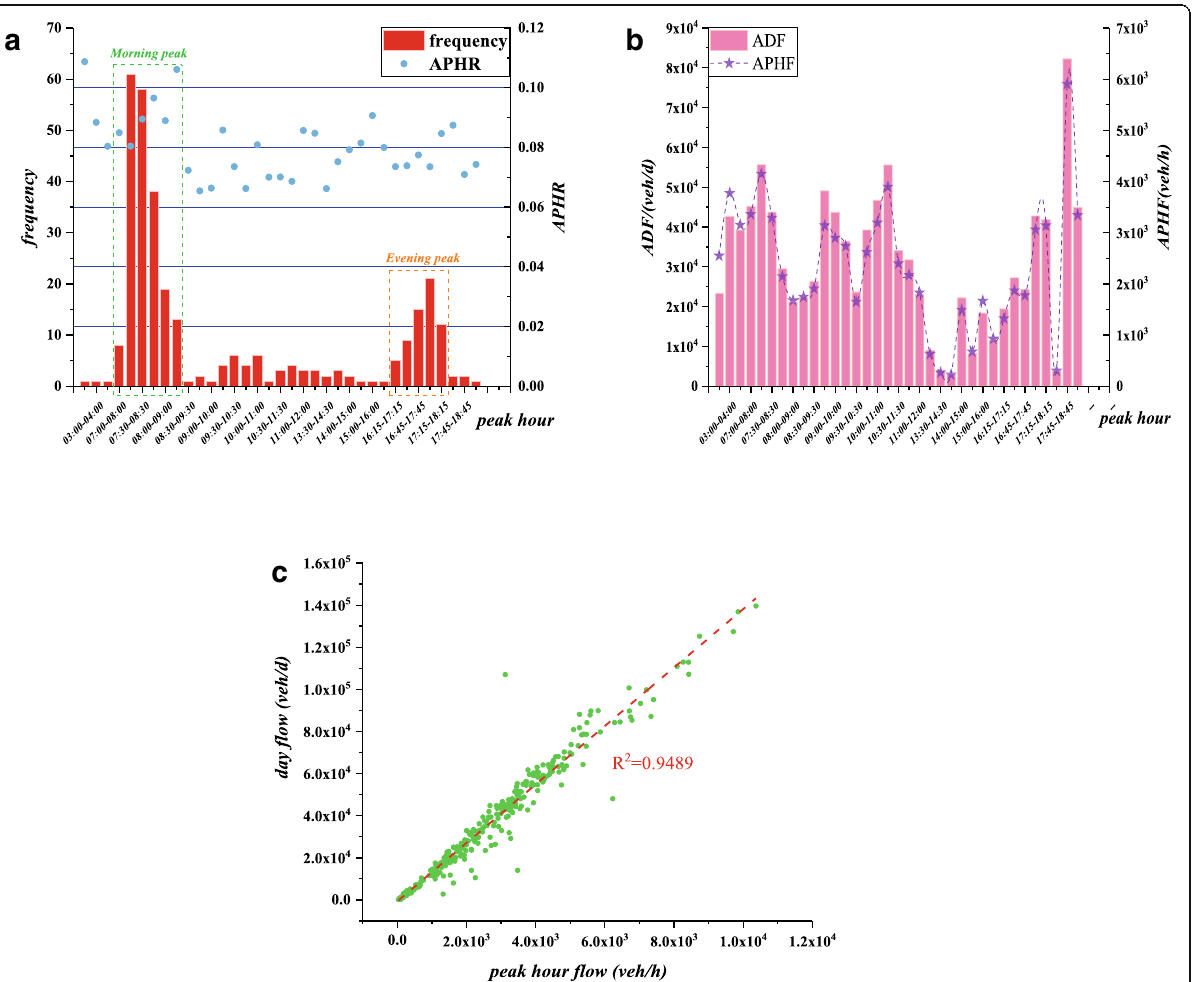
Fig. 5 Whole day time characteristics: ( a ) peak hour distribution and APHR (average peak hour ratio), ( b ) correlation between average peak hour flows (APHF) and average daily total flows (ADF), and ( c ) correlation between peak hour flows and day